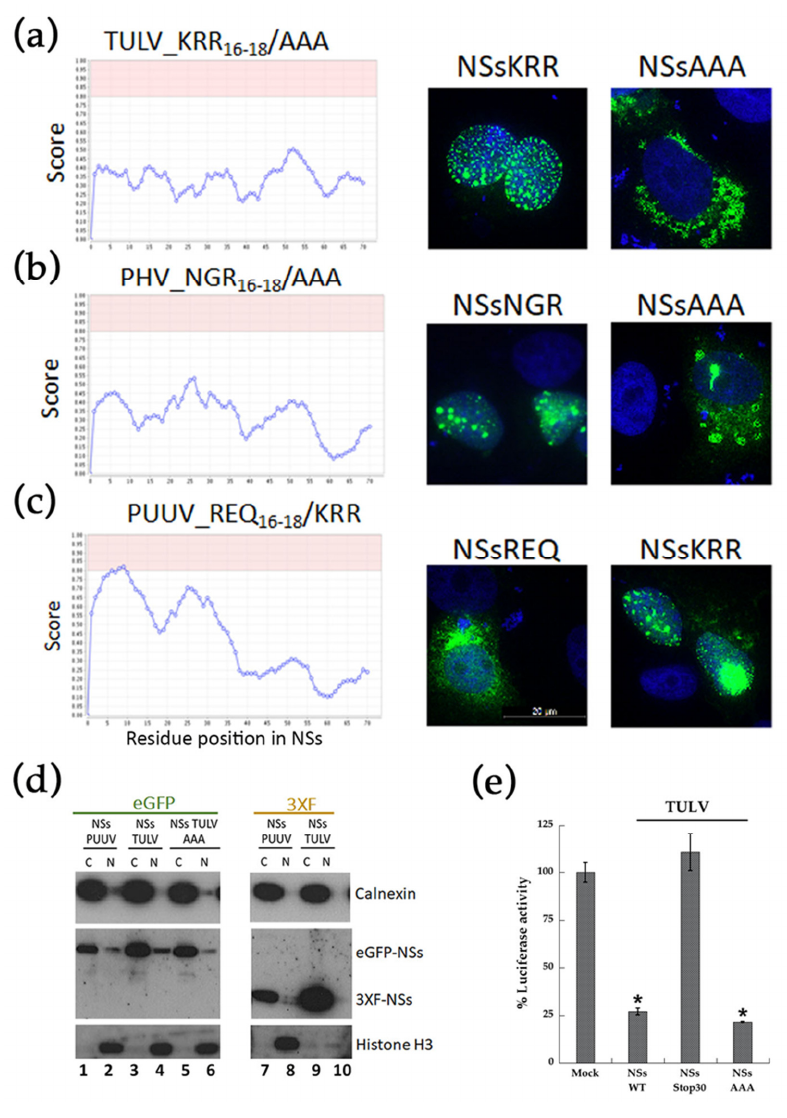
Figure 5. Role of NoLS in perinuclear localization of TULV, PHV and PUUV eGFP-NSs. The polar residues KRR, or NGR at positions 16–18 of TULV and PHV NSs proteins, were replaced with neutral amino acids AAA by site-directed mutagenesis. In silico analysis of an absence of NoLS motif in the engineered NSs AAA 16–18 sequences is shown in the left panel of ( a ) for TULV and ( b ) for PHV. The cellular localization in VeroE6 cells transfected with 500 ng of the corresponding plasmids encoding eGFP-NSS AAA 16–18 , as compared to the wild type counterpart KRR 16–18 for TULV and NGR 16–18 for PHV, is shown in the right panels of ( a , b ), respectively. In ( c ) is shown a reverse approach introducing KRR residues at amino acid positions 16–18 of PUUV NSs. Both, in silico analysis (left panel) and immunofluorescence staining of VeroE6 cells (right panel), transfected with PUUV eGFP-NSs KRR 16–18 construct, were performed. The nuclei were stained in blue with DAPI and the different eGFP NSs proteins emitted green fluorescence. In ( d ) VeroE6 cells transfected with 3 µ g of plasmid constructs encoding the eGFP- or 3xFlag-NSs of PUUV or TULV with wild type or mutated NSs AAA 16–18 sequence were tested by immunoblotting as indicated. Cytoplasmic (C) and nuclear (N) fraction enrichment was determined by the imunodetection of specific markers: calnexin for the cytoplasmic compartment and histone H3 for the nuclear compartment, while eGFP-NSs or 3xFlag-NSs were detected using tag specific antibodies. In ( e ) the different TULV NSs variants (WT, NSsStop30 or AAA 16–18 ) were tested for their capacity to inhibit the IFN β -Luc activity induced by RIG-I. Statistics were performed on replicates of at least three independent experiments and data represent mean +/ − standard deviation to the mean (* = p <